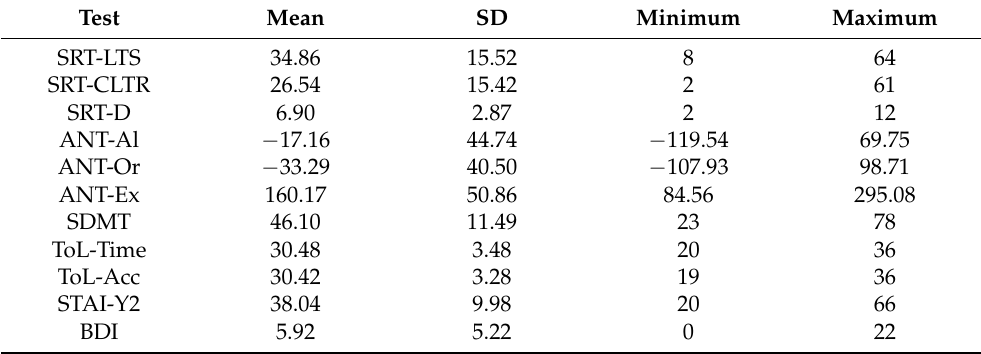
Table 2. Means, standard deviations (SD), and range values of the neuropsychological and psycholog- ical tests’ scores in participants with OSAS ( n = 50). SRT-LTS: Selective Reminding